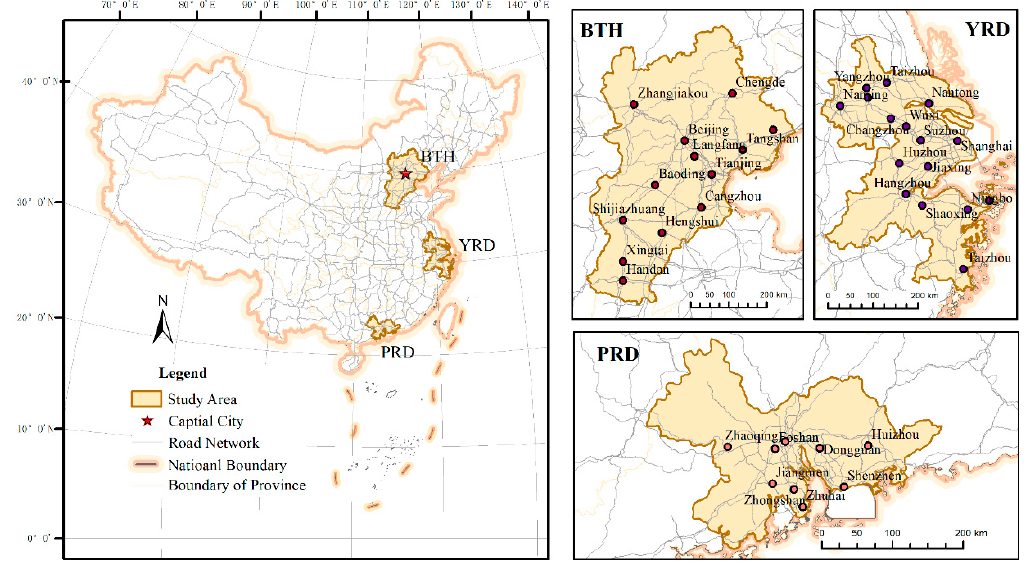
Figure 1. Locations of the study area.